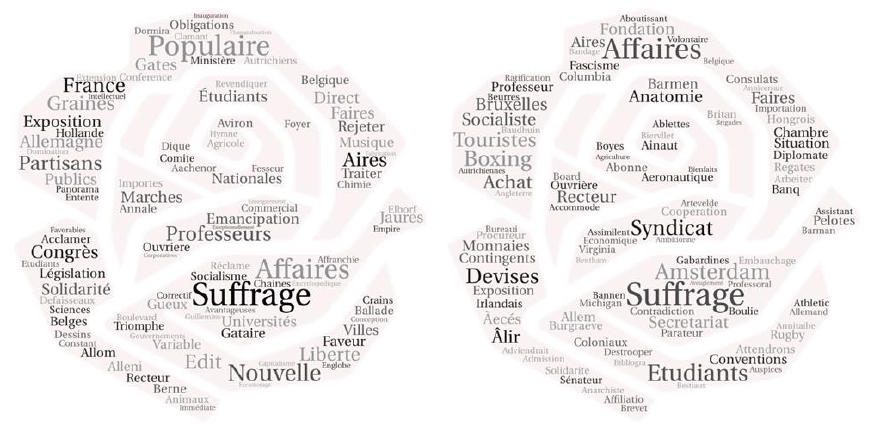
Figure 8: Key associations with topic internationalism in Le Peuple (1886-1938). Left: before WW 1. Right: Fig. 8 1918-1938.